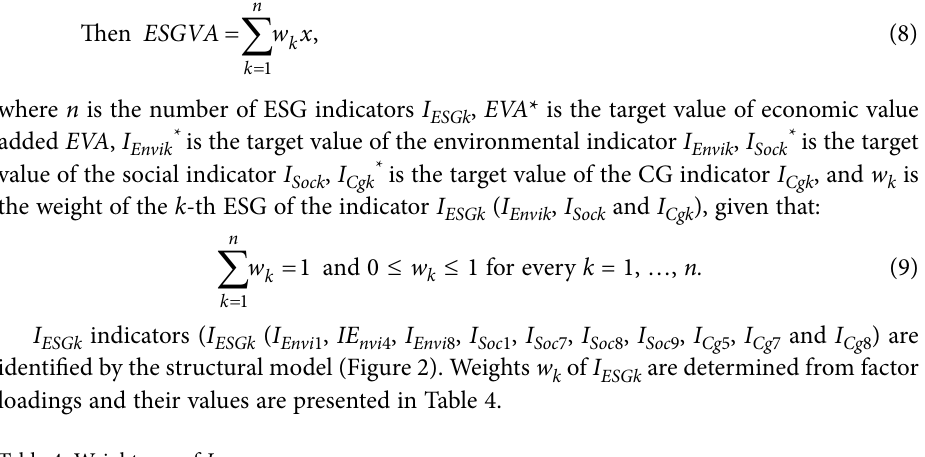
Table 4. Weights w k of I